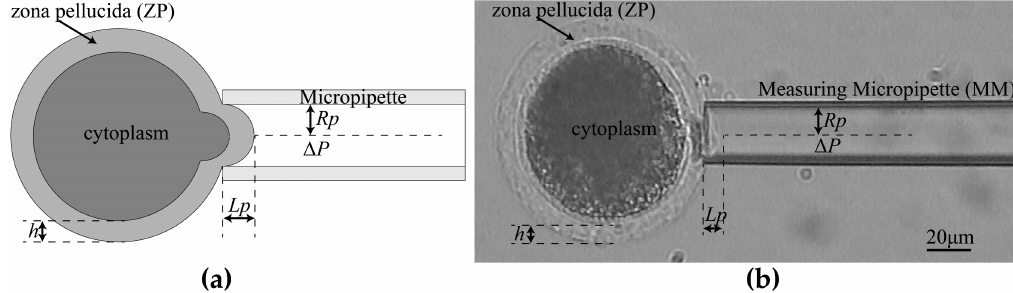
Figure 9. Automated aspiration of the oocyte. ( a ) Diagram of the shell model using to estimate the Young’s modulus of the zona pellucida of the oocyte. ( b ) The MA of porcine oocytes.